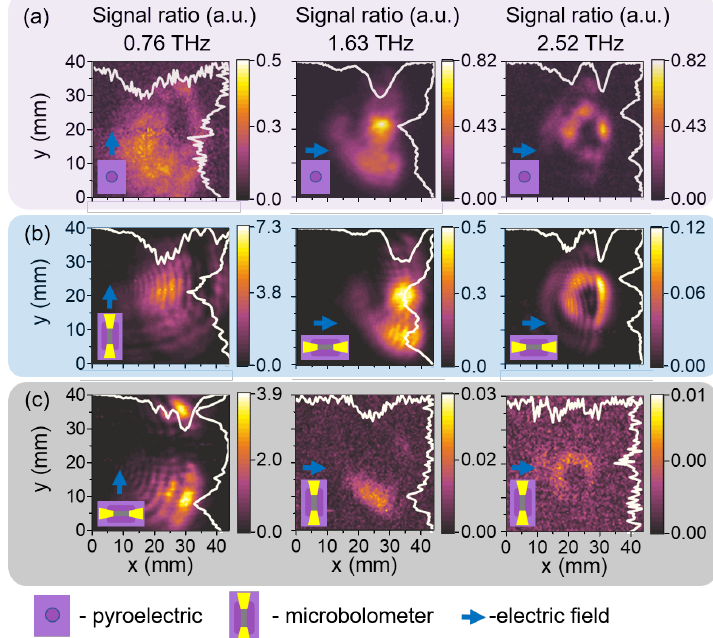
Figure 6. THz beam profiles of different polarizations obtained using optically-pumped molecular THz laser operating in a continuous wave mode at frequencies: 0.76 THz, 1.33 THz and 2.52 THz. Reference measurements using pyroelectric detector ( a ); results using microbolometer when the dipole antenna is in parallel to the electric field of the incident light ( b ); results using microbolometer when the dipole antenna is perpendicular to the electric field of the incident light ( c ). White lines indicate intensity cross sections along the relevant